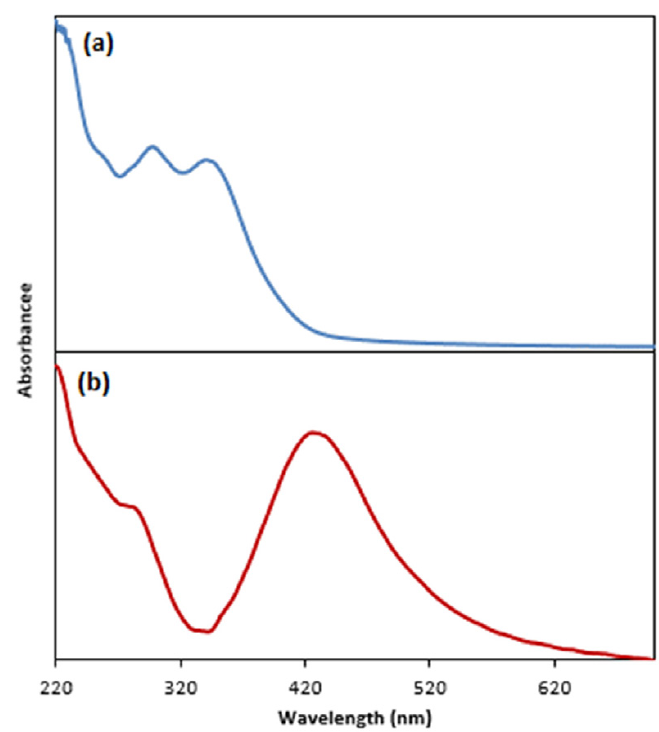
Fig. 2. UV-Vis spectrum of Tragopogon graminifolius extract (a), and green synthesized Ag NPs using Tragopogon graminifolius extract (b)